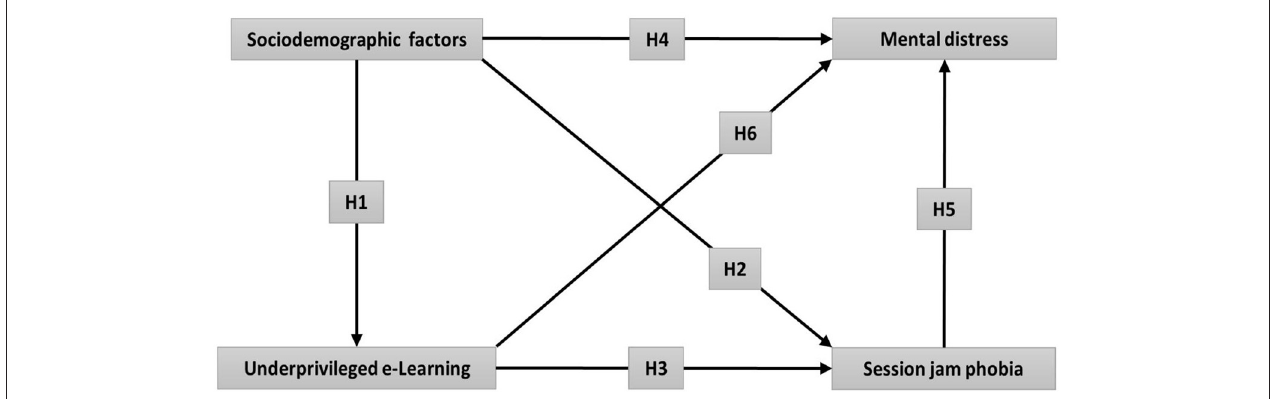
FIGURE 1 | Mediating role of associated factors following prolonged COVID-19 lockdown on underprivileged online education, session jam phobia (SJP), and mental distress among university students in Bangladesh.